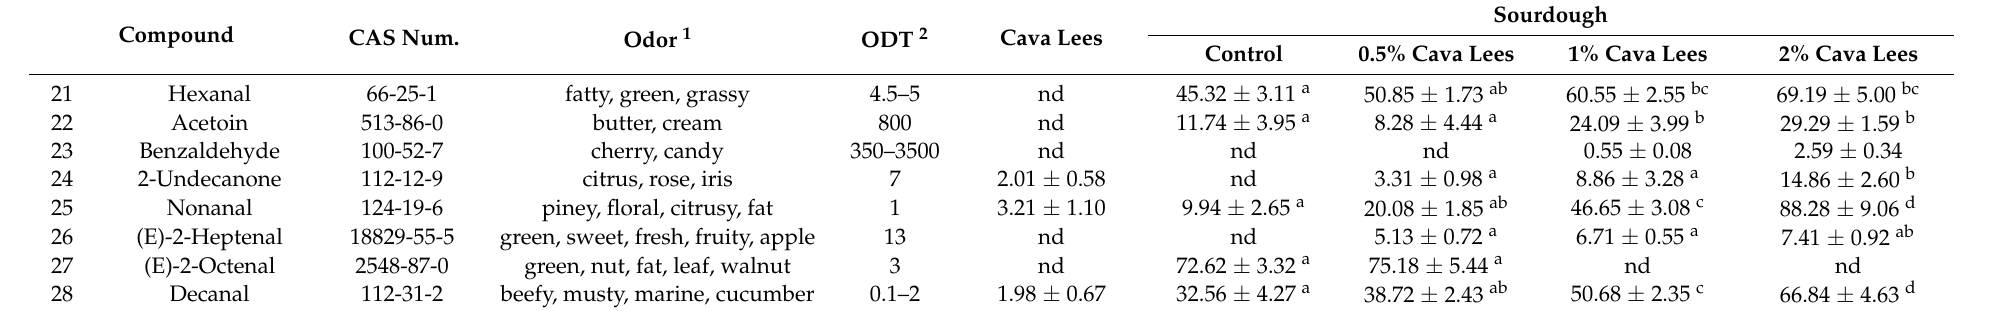
Table 4. Concentration (mg/kg) of main aldehydes and ketones obtained with the optimized extraction parameters in Cava lees and sourdough. Compound CAS